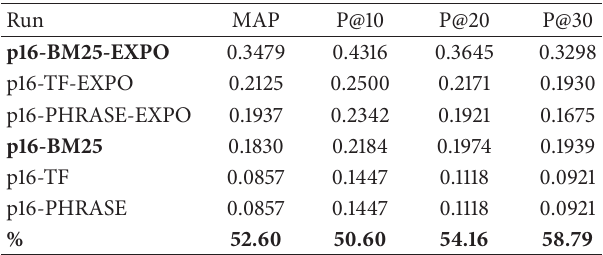
Table 4: Compare performing runs based on MAP with and without the exponentiation.